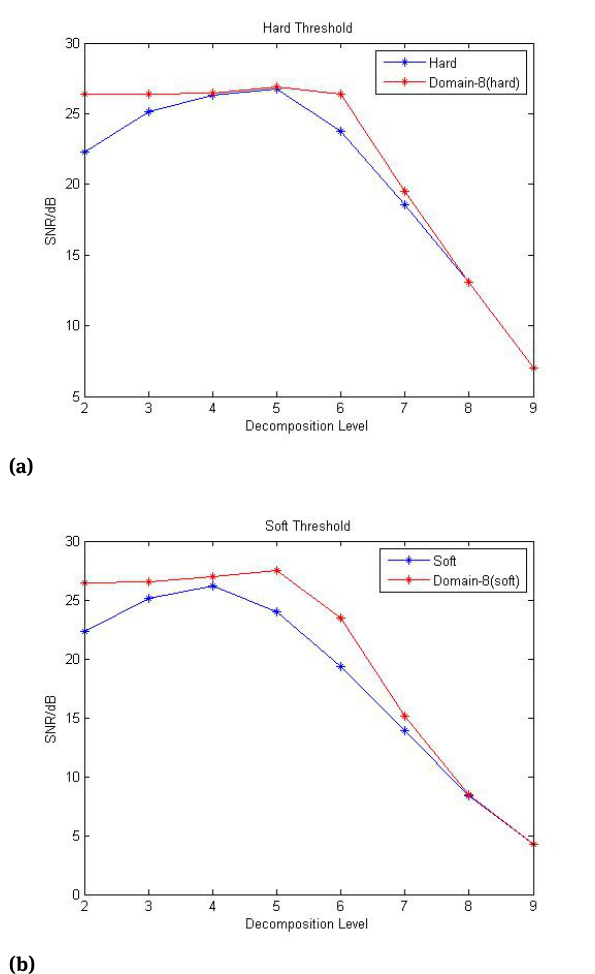
Figure 3: Comparison between wavelet threshold results and domain-wavelet results by using hard threshold (a) and soft thresh- old (b).